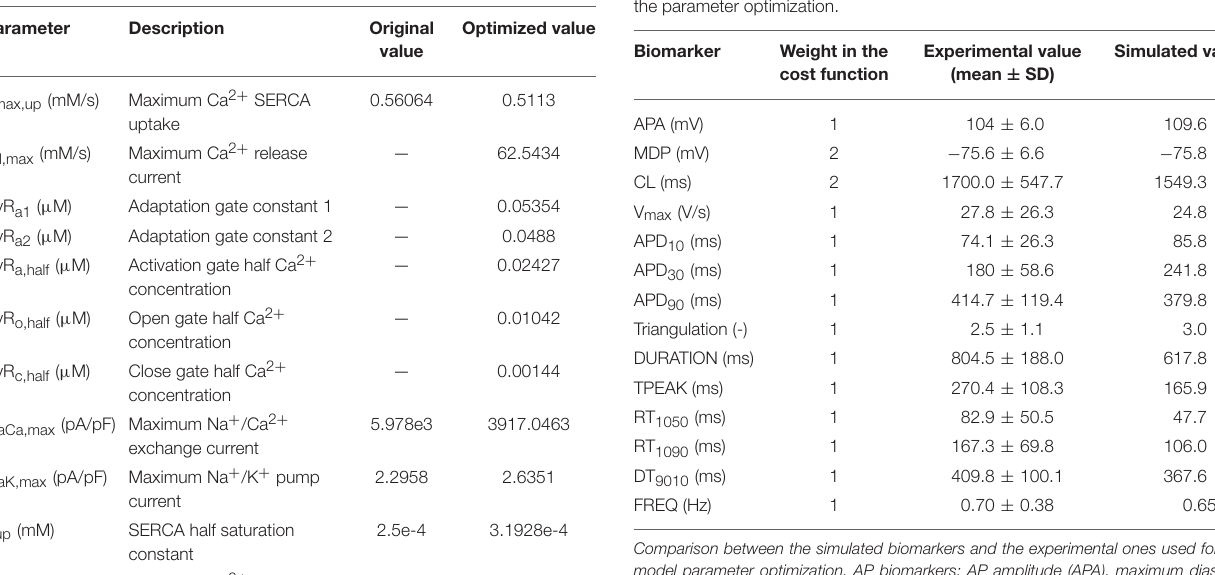
TABLE 1 | Parameters chosen for optimization. TABLE 2 | Experimental and simulated values of the biomarkers considered for